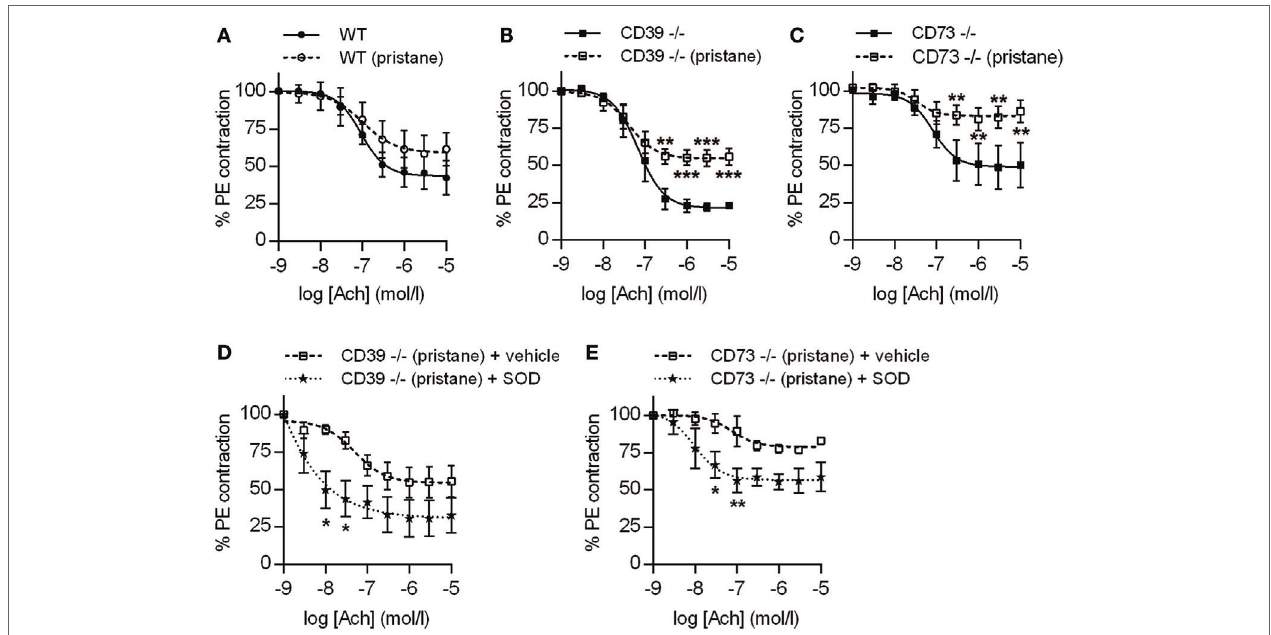
FigUre 5 | Ectonucleotidase deficiency potentiates endothelial dysfunction in pristane-treated mice. Mice were administered either saline or pristane, as indicated. 36 weeks later, “aortic rings” were harvested for ex vivo determination of endothelial function by measuring the contractile force remaining in pre-contracted (by phenylephrine/PE) aortic rings in response to progressively increasing concentrations of acetylcholine. A “deeper” curve indicates a healthier endothelium, while a “flatter” curve denotes endothelial dysfunction. (a–c) N = 5 control mice and 7 pristane mice per graph. (D,e) Two aortic rings were isolated from each mouse ( n = 5), and one was treated with superoxide dismutase (SOD). * p < 0.05, ** p < 0.01, and *** p <